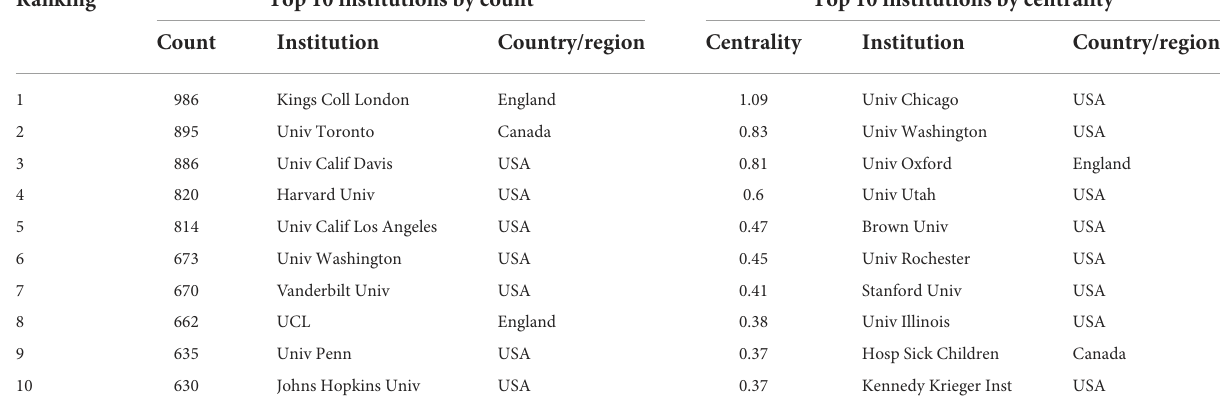
TABLE 1 The top 10 institutions by count or centrality in ASD research.